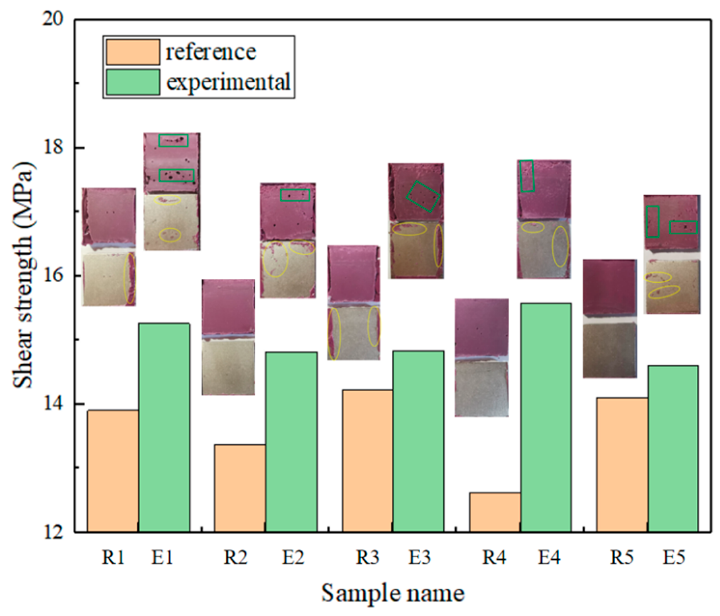
Figure 9. Shear strength and failure of adhesive joints in the experimental and reference groups.